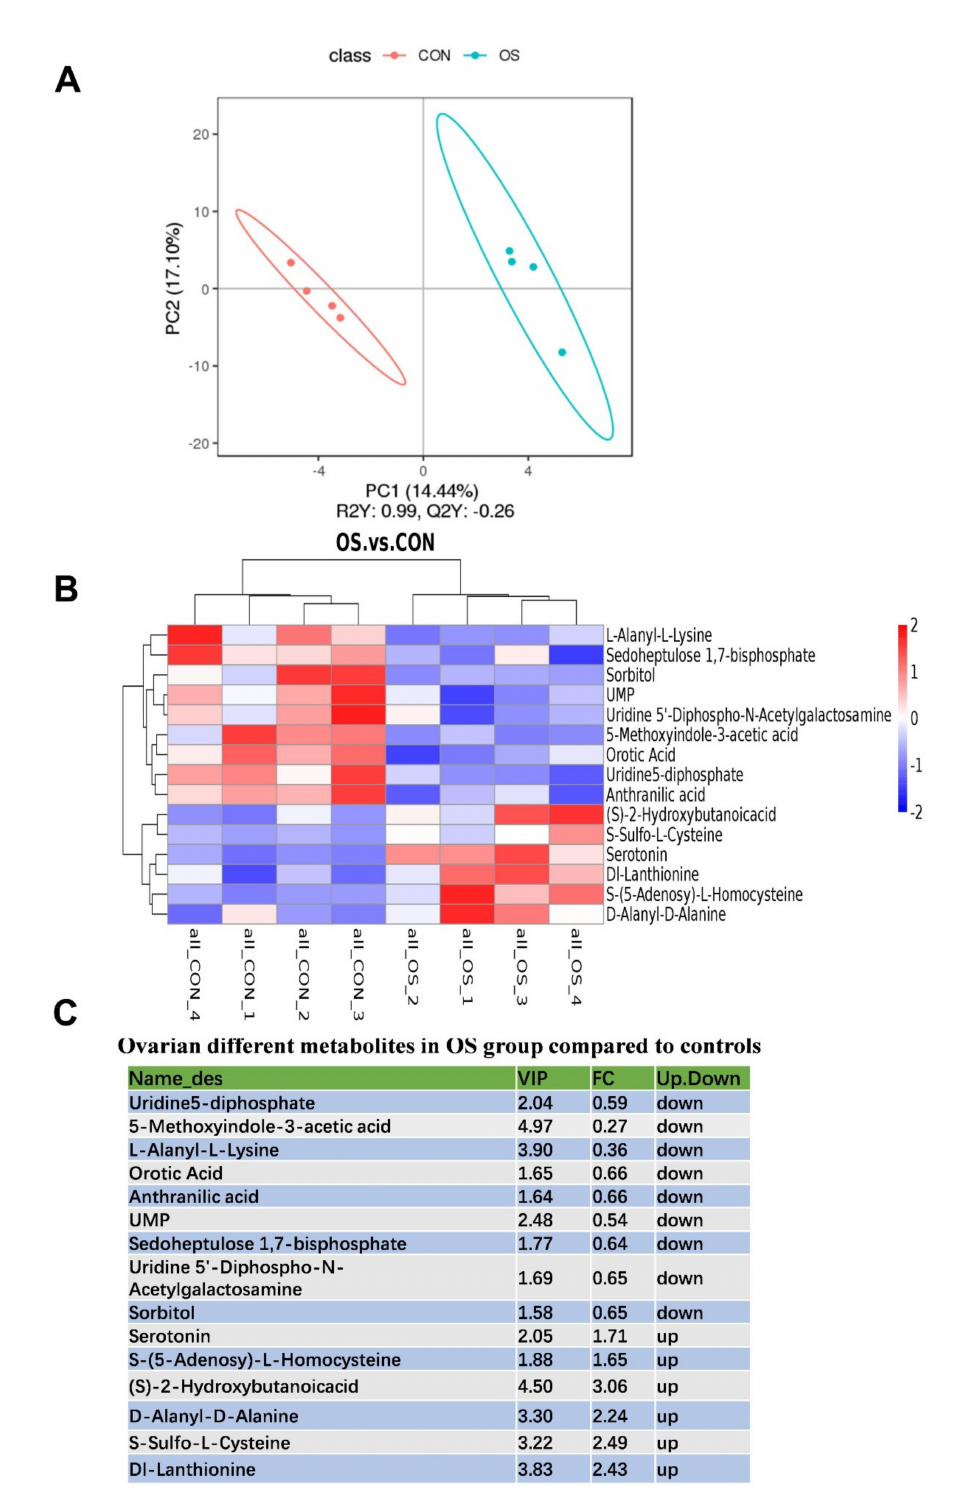
Figure 7. Oxidative stress (induced by tBHP) changed the serum metabolites. ( A ) The principal component analysis (PCA) of the serum metabolites. ( B ) Heatmap of the different serum metabolites. ( C ) Ovarian different metabolites in OS group compared to controls. p <